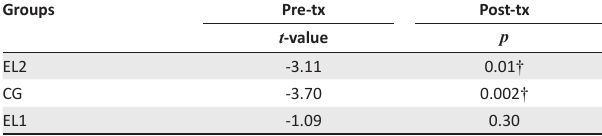
FIGURE 1: Average scaled scores of word discrimination of all participants across all groups. TABLE 1: Results of t -tests for significant differences in pre- and post-intervention word discrimination scores within groups.